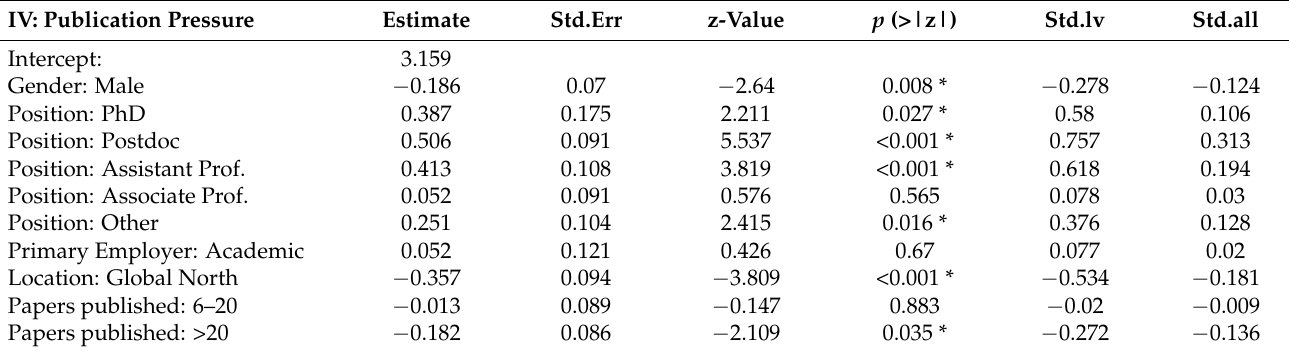
Table 3. Extracted output for the independent variable “Publication Pressure” from the regression analysis of our SEM model. * indicates statistical significance ( p <